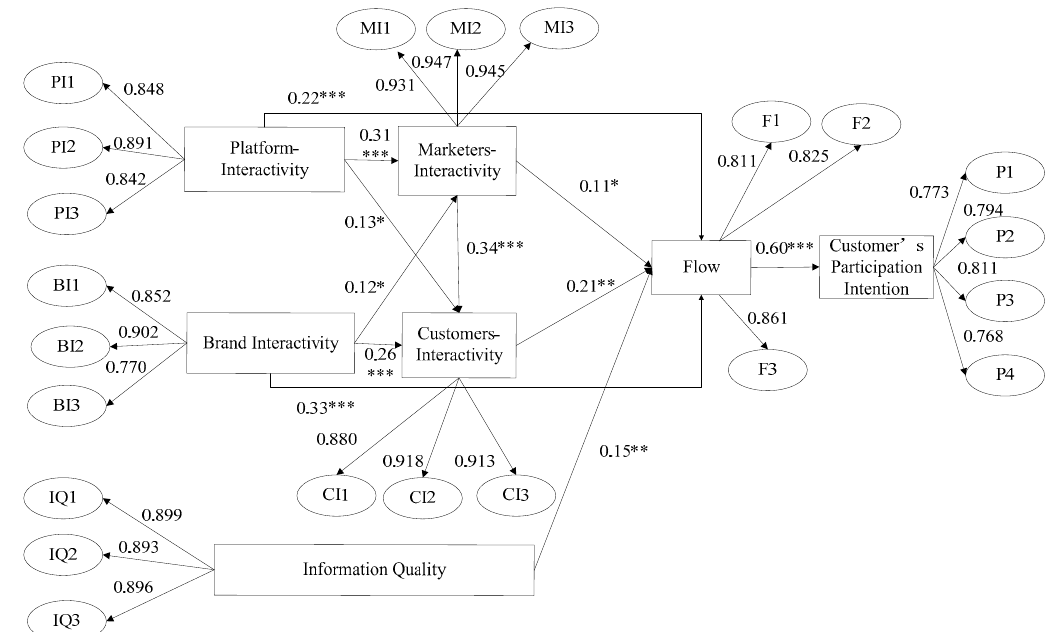
Figure 2. Model testing results by SmartPLS. Note: * p < 0.05; ** p < 0.01; *** p < 0.001; n.s = not significant. Table 4. Goodness of model fit.